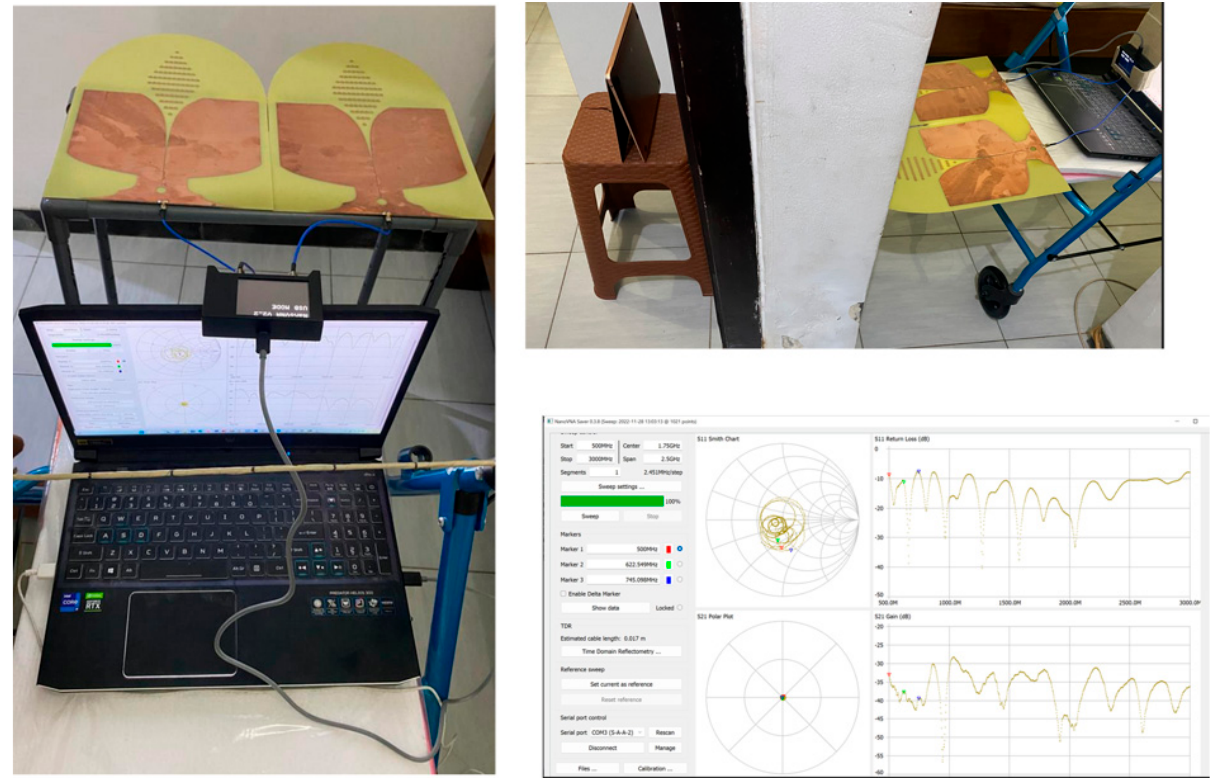
Figure 15. Radar target measurement with MLPT-CVA prototype.